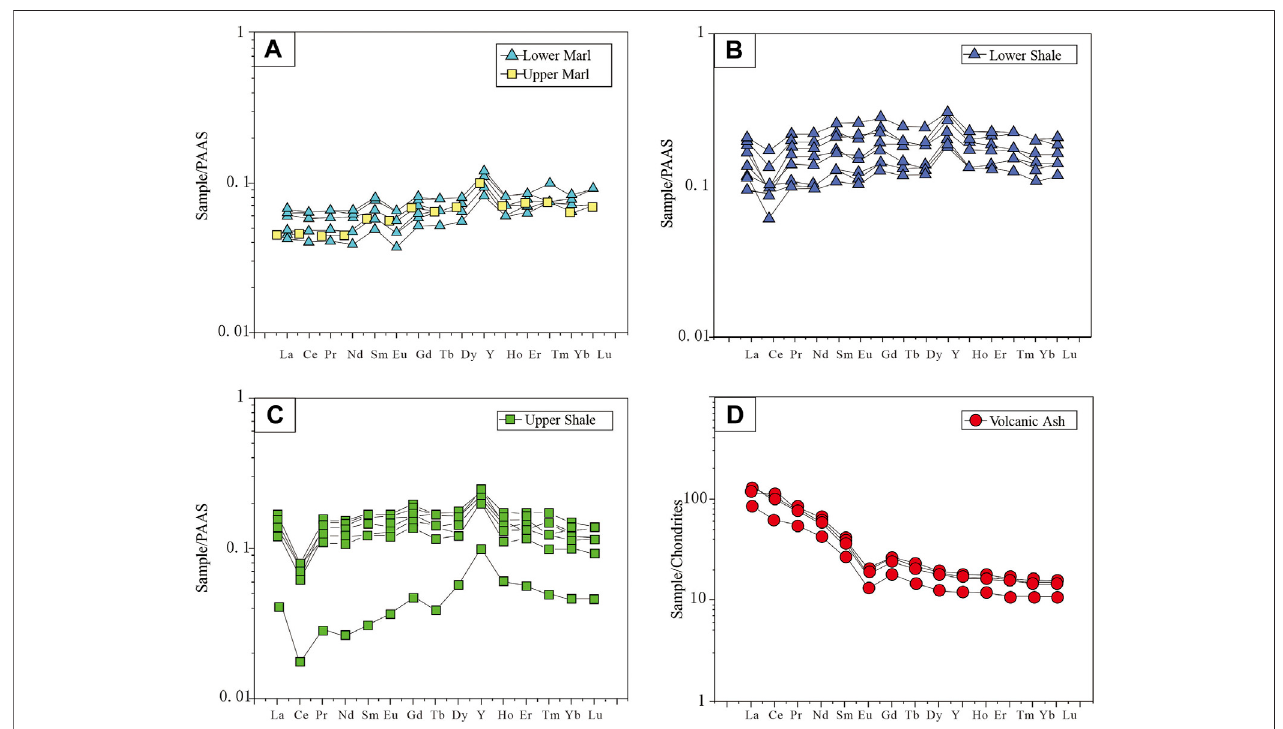
FIGURE 6 | REE patterns of the volcanic ash and overlying and underlying rocks in the Lengshuixi section of the Maokou Formation. PAAS represents post- Archean Australian shales with their REE data taken from Taylor and McLennan (1986); chondrite REE data are taken from Boynton (1984) (A) . low and upper marl; (B) .lower shale; (C) .upper shale; (D) .volcanic